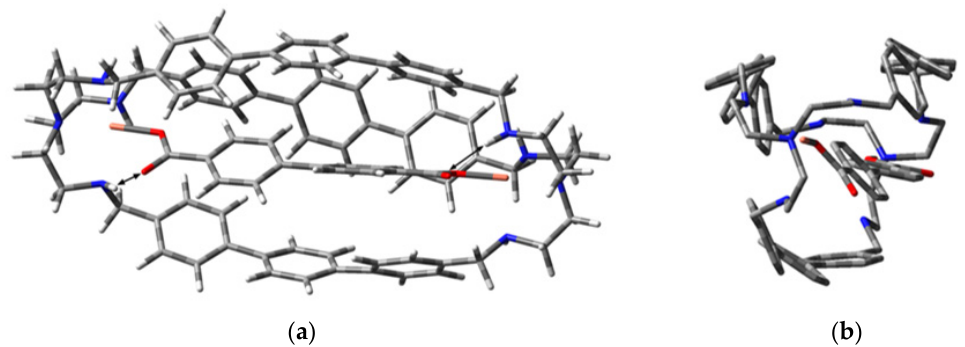
Figure 6. Lateral ( a ) and front ( b ) views of the calculated structure of the complex [Cu 2 L(dfc)] 2+ .